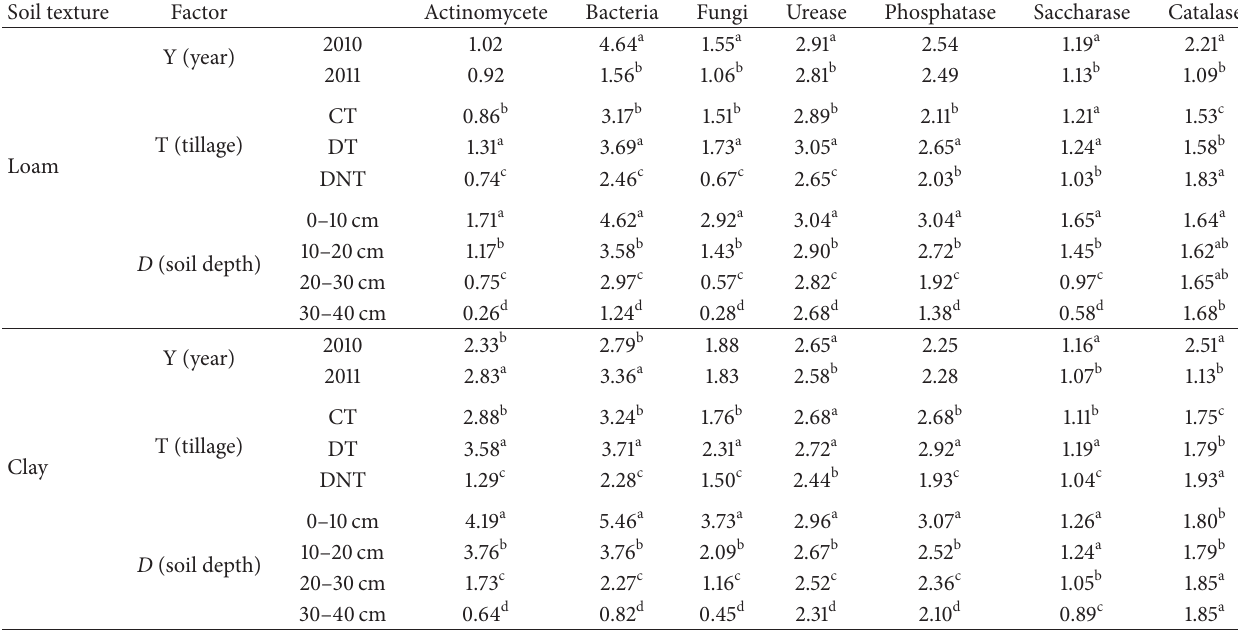
Table 1: Differences of tillage, year, soil depth, and soil texture on soil microorganism and enzyme activities. Soil texture